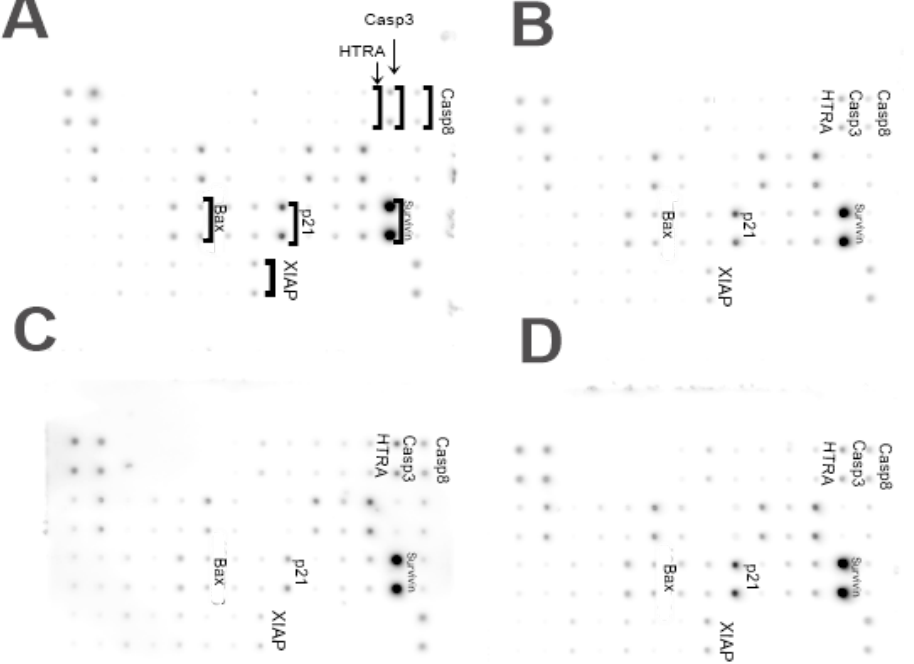
Figure 9. Analysis of the expression of apoptotic proteins of MDA-MB-231 cells. ( A ) Control group; ( B ) group treated with melittin at a concentration of 10 mg / L, ( C ) group treated with a melittin complex (10 mg / L) and natural graphene (20 mg / L); ( D ) group treated with melittin complex (10 mg / L) and nanodiamond (20 mg /